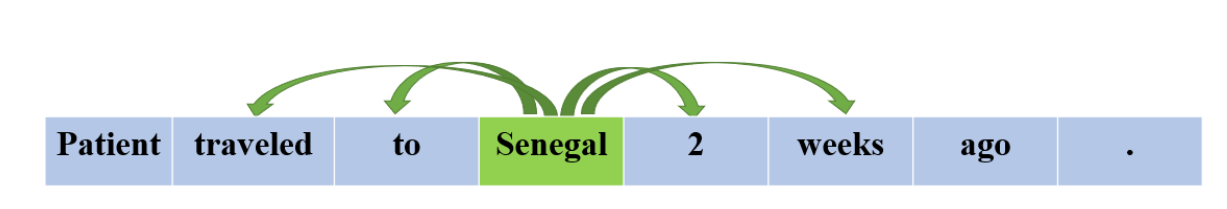
Figure 3. Illustration of feature encoding window for the token "Senegal" in an example sentence.